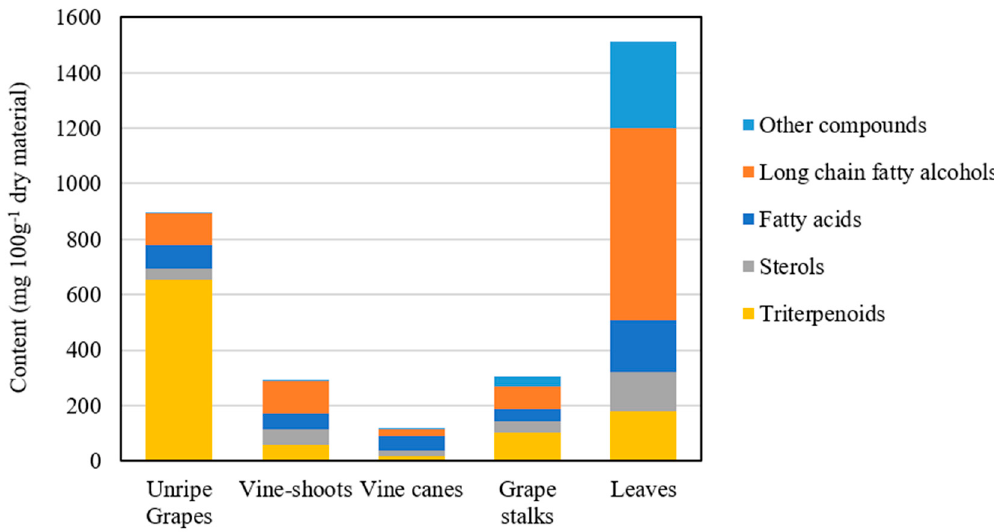
Figure 2 . Major families of the lipophilic components identified in the V. vinifera unripe grape, vine shoot, vine cane, grape stalk and leaf extracts (mg/100 g of dry